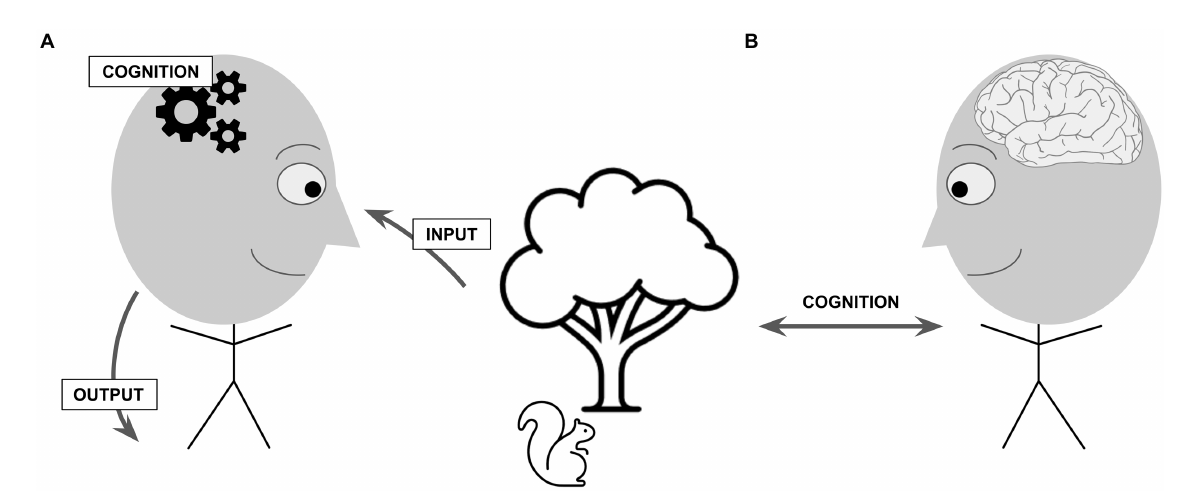
FIGURE 5 An illustration of competing views of “cognition,” (A) understood computationally in terms of representational states and procedures internal to the organism, or (B) understood in epistemic terms as a relation of acquaintance or familiarity that holds between an individual and the world. Depending on the particular computational model, the states and processes posited may be understood more or less abstractly, and more or less in connection to neurophysiological descriptions, and so on. In the relational perspective, although the organismic contribution is crucial (including perception-action in all its bodily and neurophysiological dimensions), cognition is not understood to exist “in the head” but rather as a feature of the organism-environment system as a